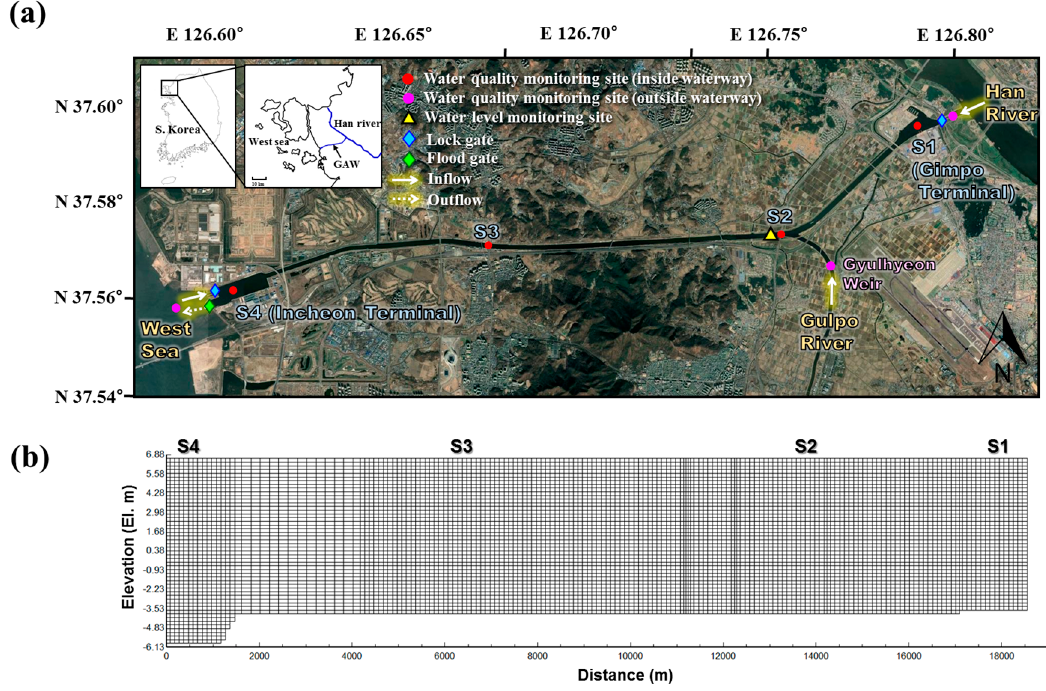
Figure 1. ( a ) Map of GAW including locations of water quality monitoring sites and hydraulic structures; ( b ) Schematic bathymetry grid of GAW.